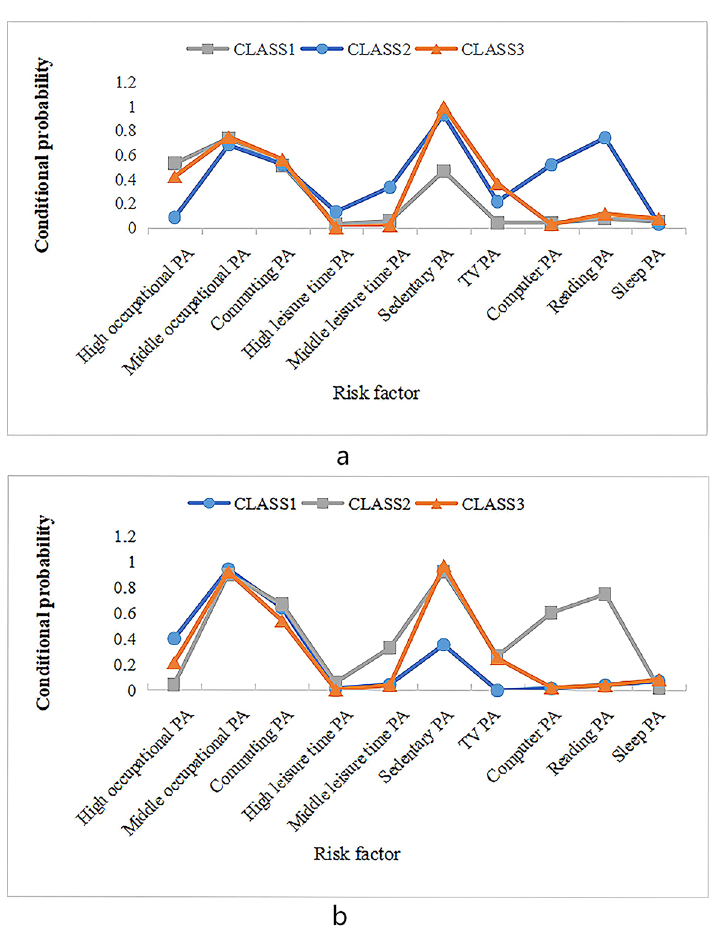
Figure 1. ( a ) Conditional probability distribution for three-category of physical activity for males; ( b ) Conditional probability distribution for three-category of physical activity for